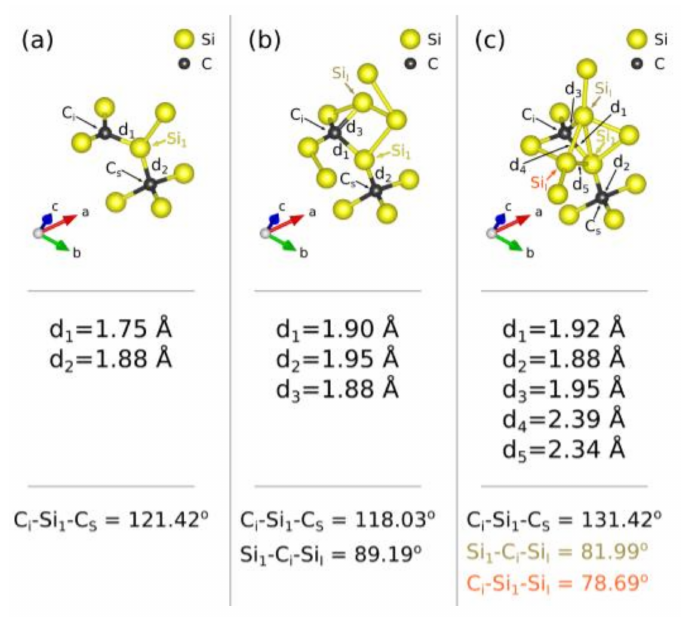
Figure 2. Schematic representation of the energetically favourable ( a ) C i C s , ( b ) C i C s (Si I ), and ( c ) C i C s (Si I ) 2 configurations. Table 1. The binding energies of the C i C s (Si I ) n defects (n = 0, 1, 2) in Si. Title BE/eV BE Difference/eV C i C s − 0.90